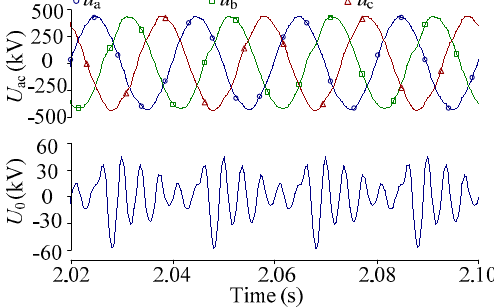
Figure 4. Zero sequence component of the converter bus voltage.